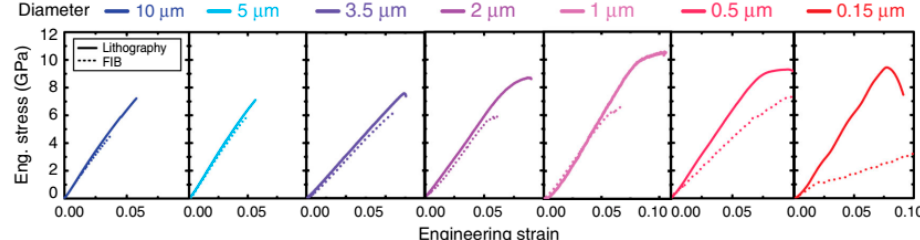
Figure 11. Single crystal silicon sample with different size and process exhibited different strength strength [107]